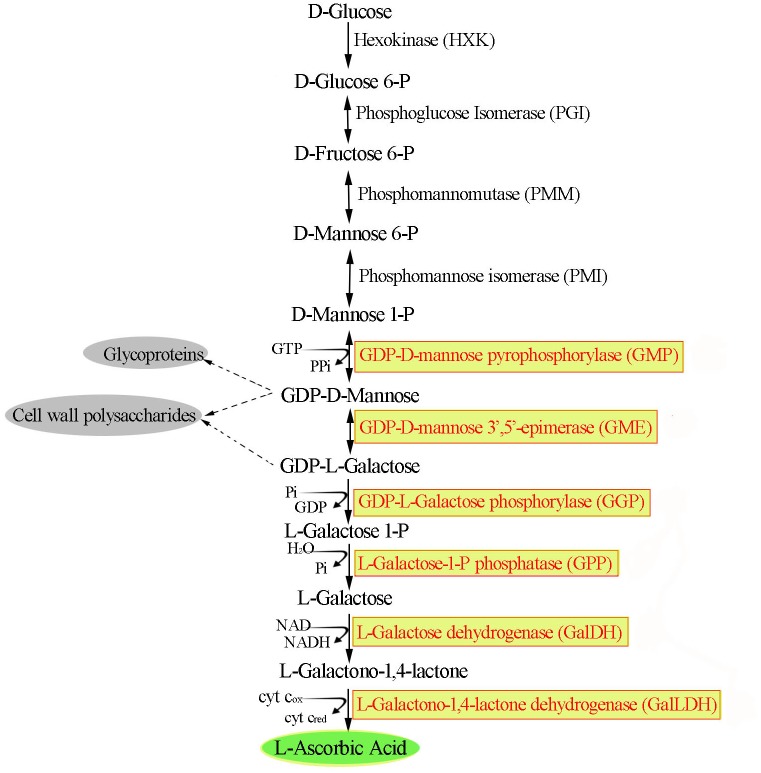
The L-galactose pathway in higher plants [14].